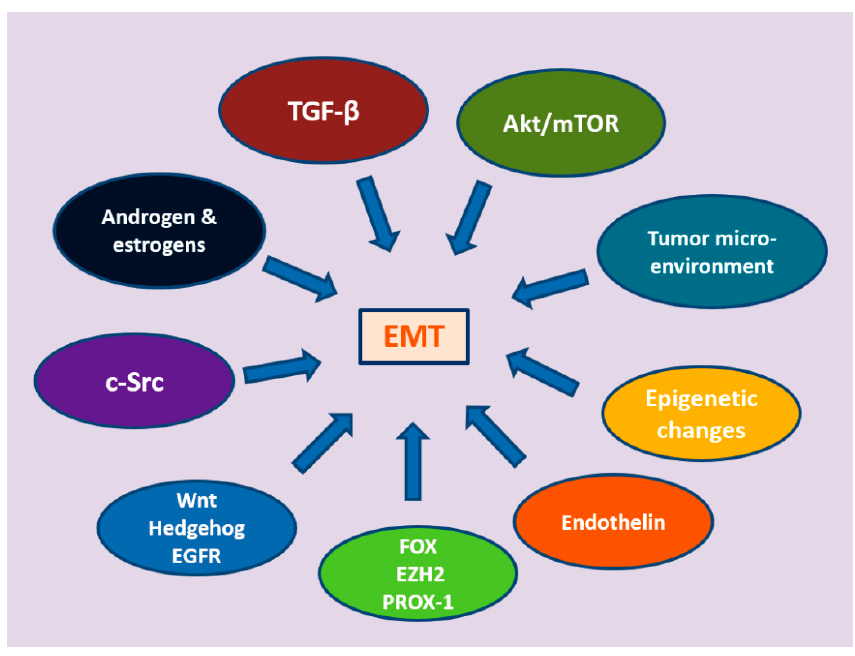
Figure 2. The multiple signaling pathways mediating epithelial-to-mesenchymal transition. Transforming Growth Factor- β (TGF- β ): A Signaling Master of